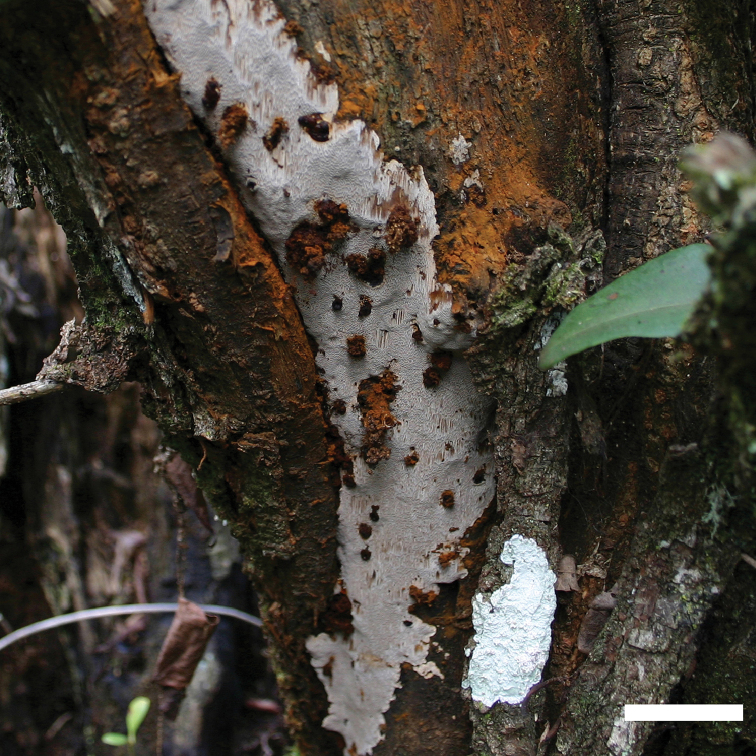
Basidiomata of Fomitiporella
mangrovei. Scale bar: 5 cm.